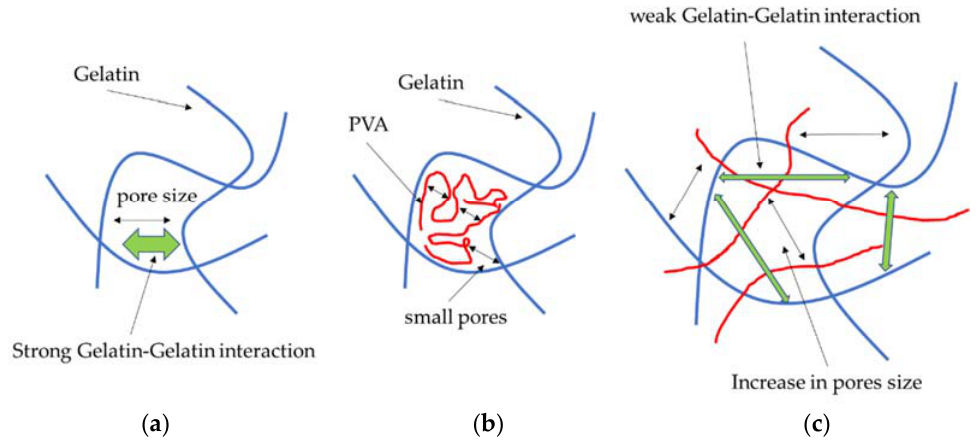
Figure 11. Model of the change in porosity within pure gelatin ( b ) and gelatin/PVA blends ( b , c ). The initial pore distribution in the gelatin blend is a result of mutual gelatin–gelatin interactions (green arrows) ( a ). The PVA interacts with gelatin via electrostatic and hydrogen interactions and fills the empty space, reducing the pore size ( b ). The screening effect of PVA increases the pore size distribution ( c ).